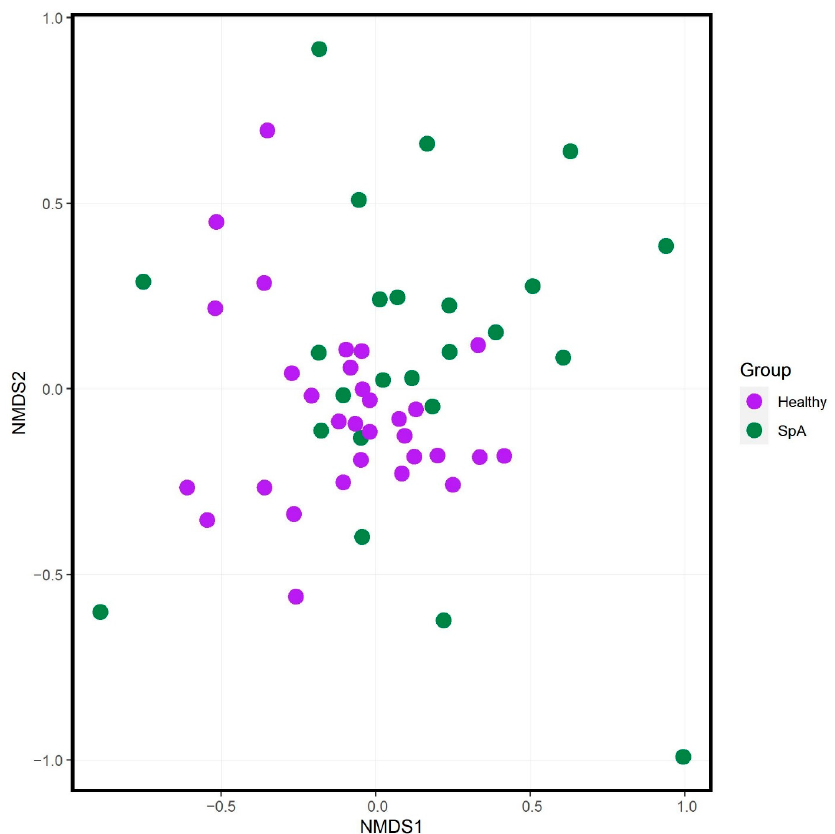
Figure 5. Ordination analysis of HLA-B27 positive healthy offspring (purple) versus HLA-B27+ SpA subjects (green). NMDS = nonmetric multidimensional scaling. Table 5. Statistically significant results of the DeSeq2 output comparing HLA-B27+ healthy offspring to HLA-B27+ SpA subjects. The full dataset is shown as Supplemental data. Abbreviations: LFC, log2Fold change; LFCSE, log2Fold change standard error; padj, adjusted (corrected) p -value. LFC values > 0 represent OTUs higher than the SpA